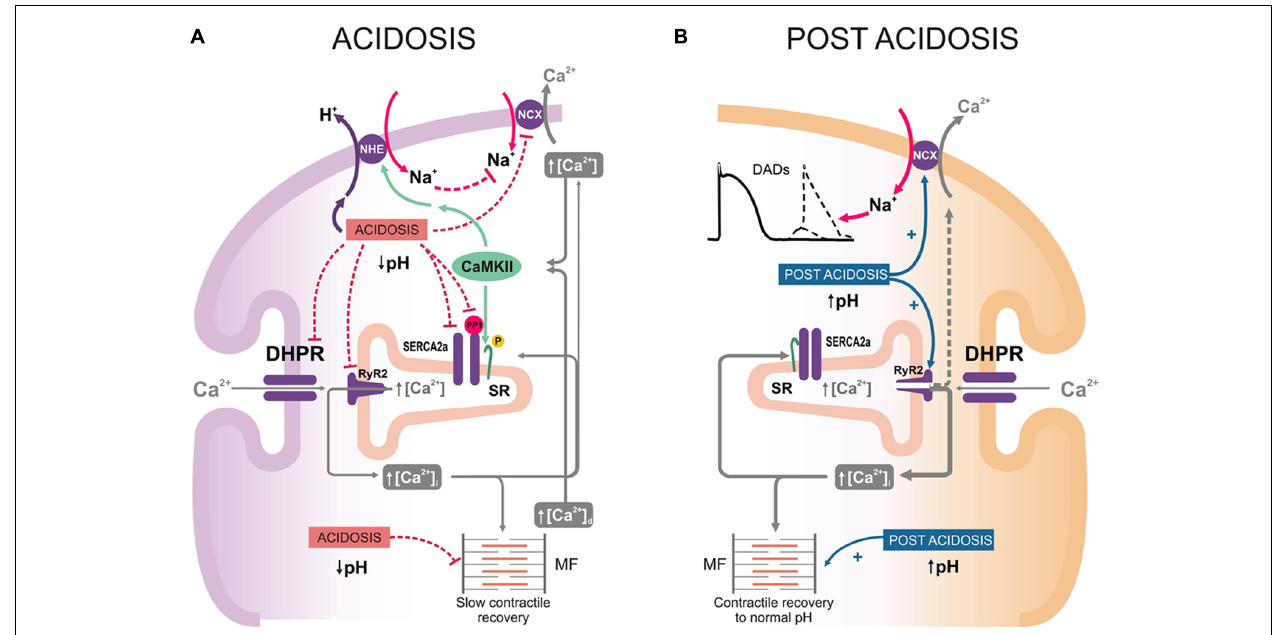
FIGURE 3 | (A) Intracellular mechanisms that may contribute to the mechanical recovery during acidosis. Acidosis produces a decrease in myofilament Ca 2 + responsiveness which increases diastolic Ca 2 + ([Ca 2 + ] d ). Activation of NHE and direct acidosis inhibition of Na + -Ca 2 + exchanger (NCX), would contribute to the increase in cytosolic Ca 2 + . Acidosis also inhibits PP1.The simultaneous increase in cytosolic Ca 2 + and inhibition of PP1 activates CaMKII and enhances PLN phosphorylation atThr 17 site. As a consequence, there is an increase in SR Ca 2 + uptake, able to offset the direct acidosis-induced inhibition of SERCA2a activity.This would lead to enhanced SR Ca 2 + release and Ca 2 + transients, which counteract the